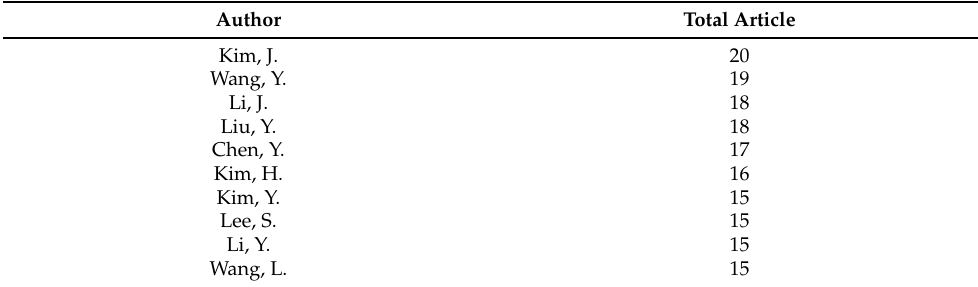
Table 2. Top ten authors based on total number of